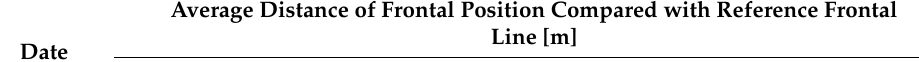
Table 1. Validation of frontal line extraction using different methods.